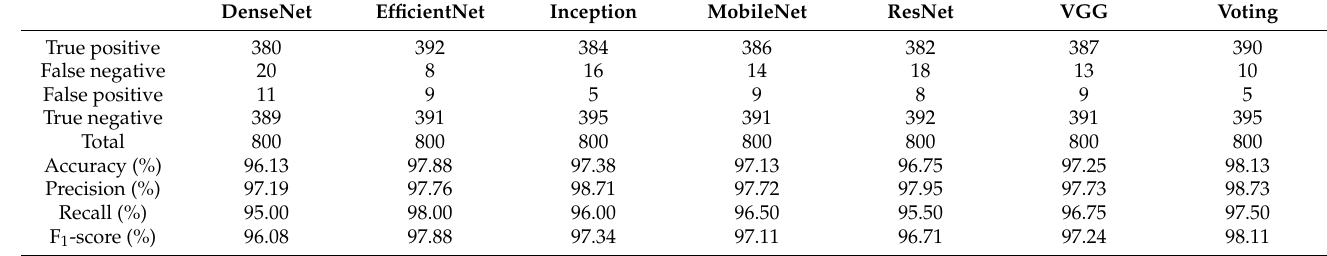
Table 8. Classification results using the soft voting ensemble classifier for test set.